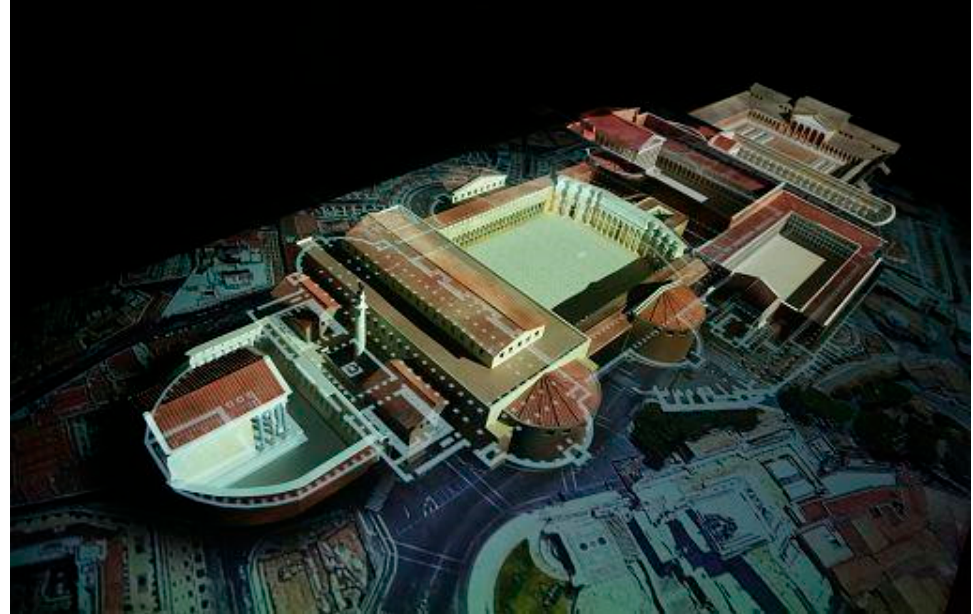
Figure 8. Welcome to Rome. Installation with real scaled model of Imperial Fora and superimposition of the Pepper’s ghost, Mizar 2017.